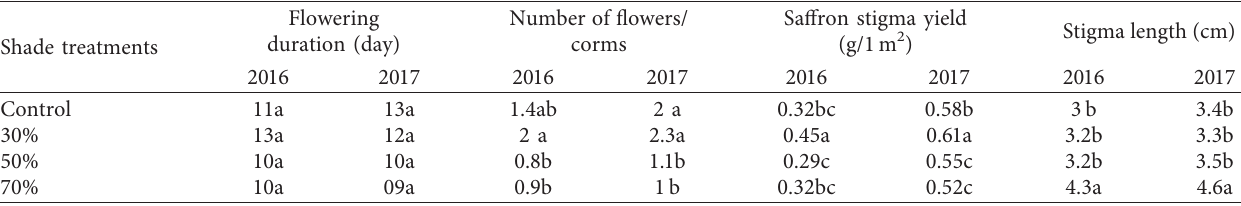
Means with the same letter within a given treatment are not significantly different at p �